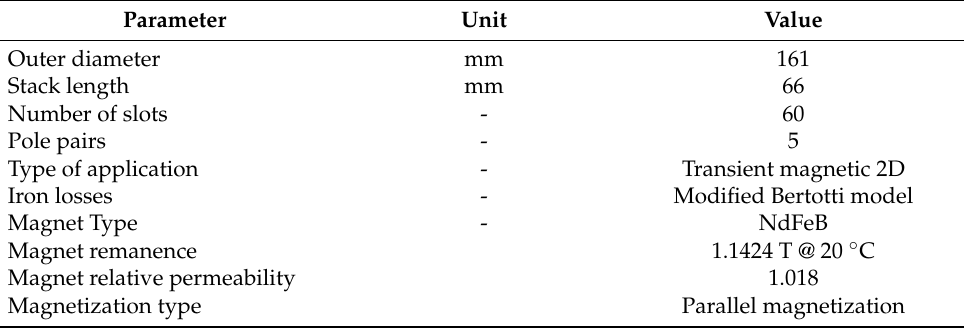
Table 1. Baseline motor electromagnetic model parameters.